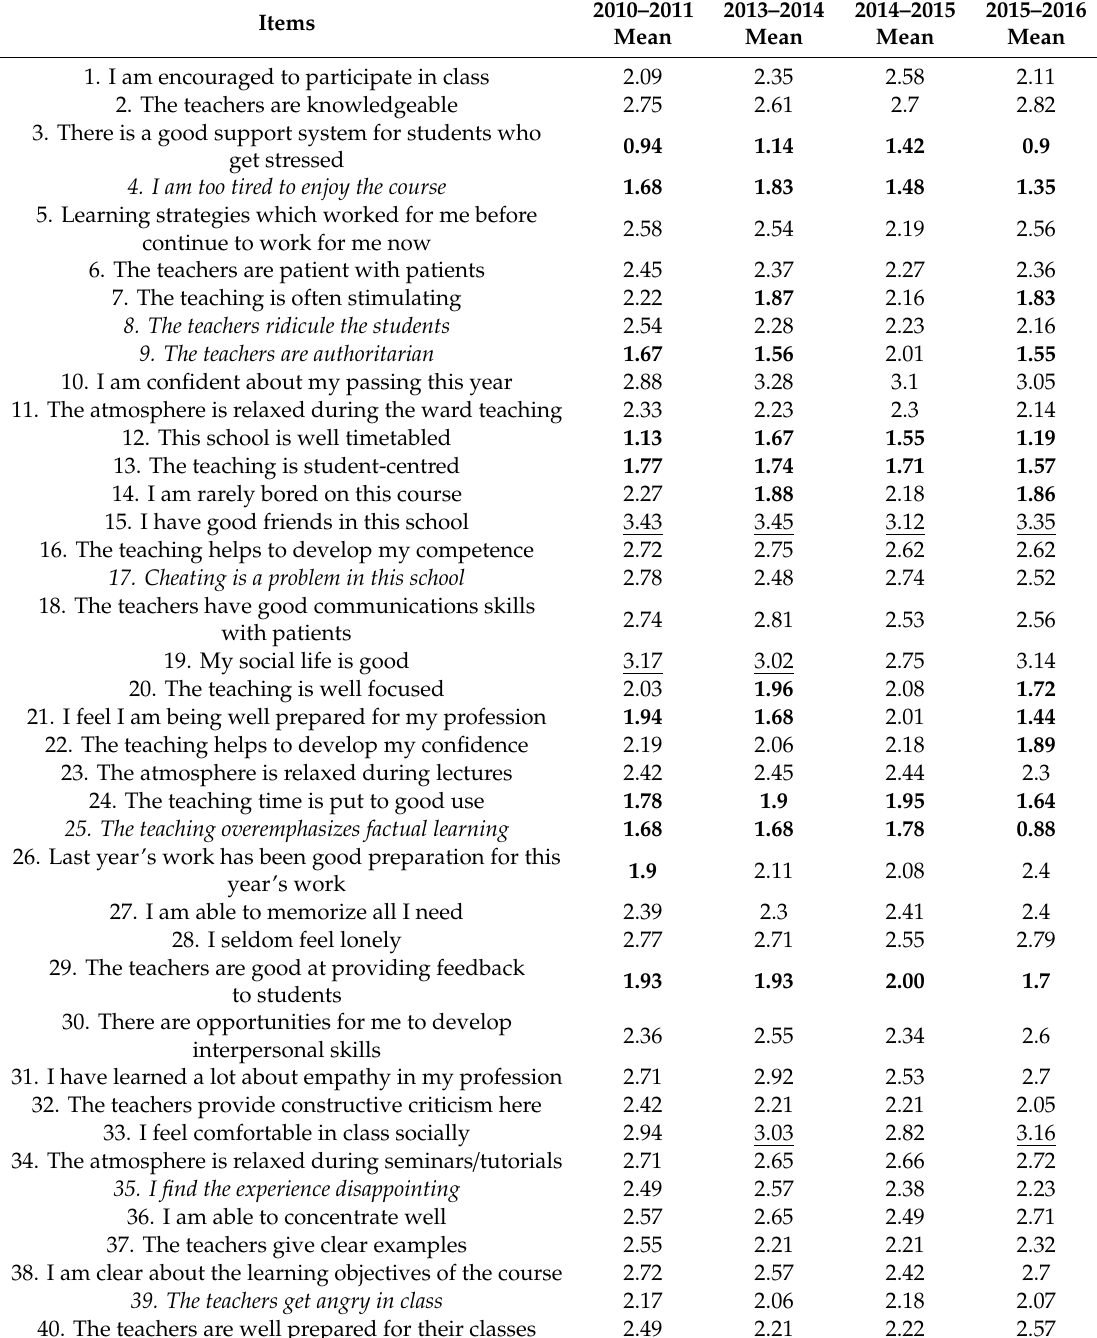
Table 2. Mean values of the 50 items of the Dundee Ready Education Environment Measure (DREEM) questionnaire based on academic